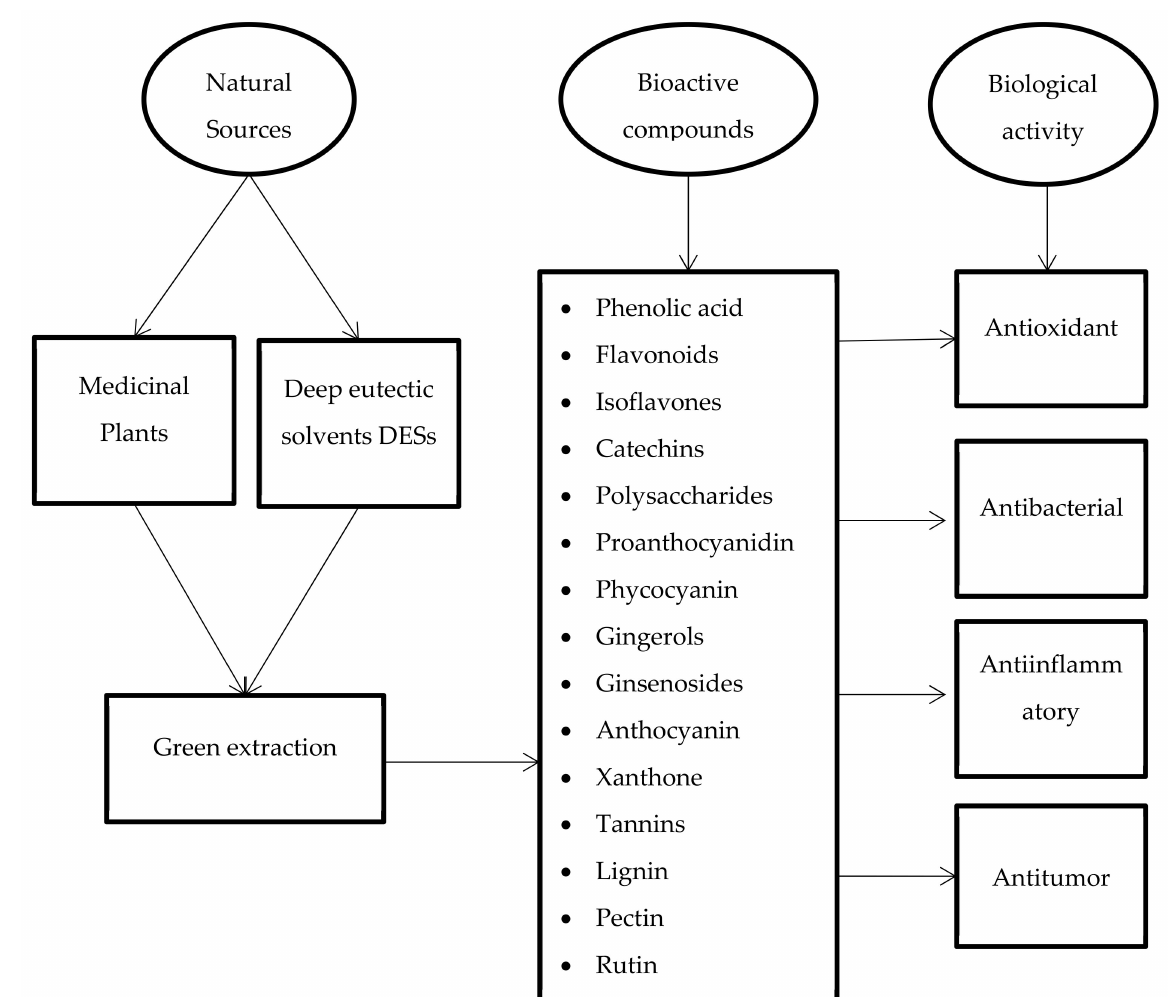
Figure 2. Steps for the green extraction media of beneficial bioactive